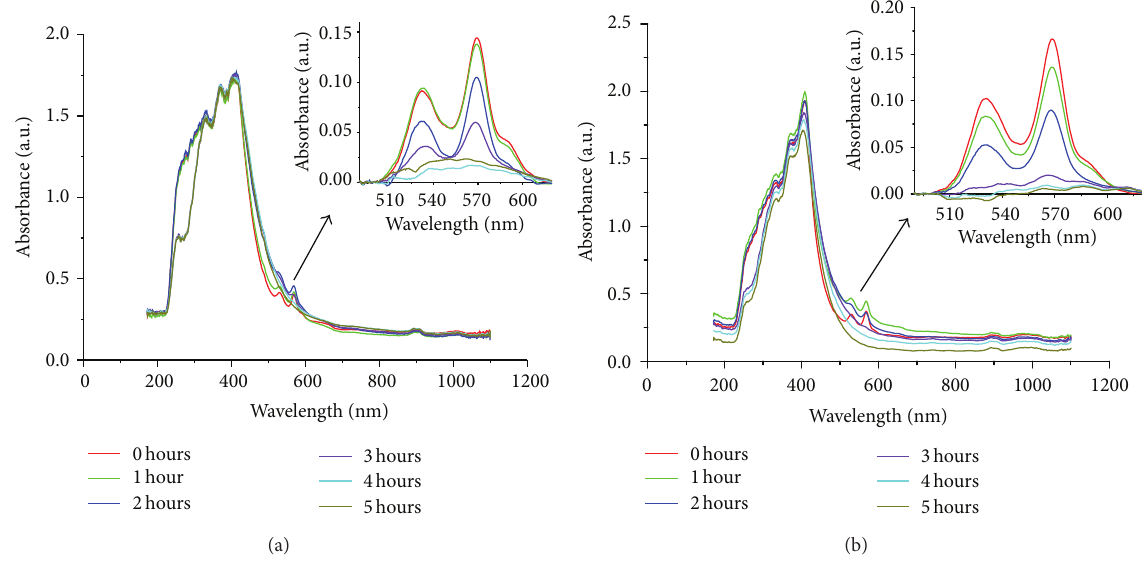
Figure 3: UV-Vis absorbance spectra as a function of illumination time of the crude oil extracts: (a) COE and (b) COEW. The insets show the bands observed at 530 nm and 569 nm with the background subtracted.